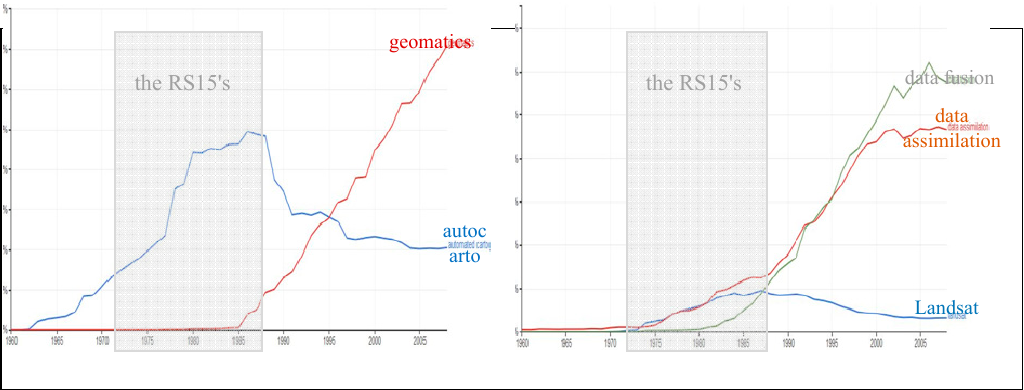
Figure 2. ( Left ) geo-information and geomatics , replace automated cartography . ( Right ) data fusion joins data assimilation , when Landsat stops being prominent, then takes over.